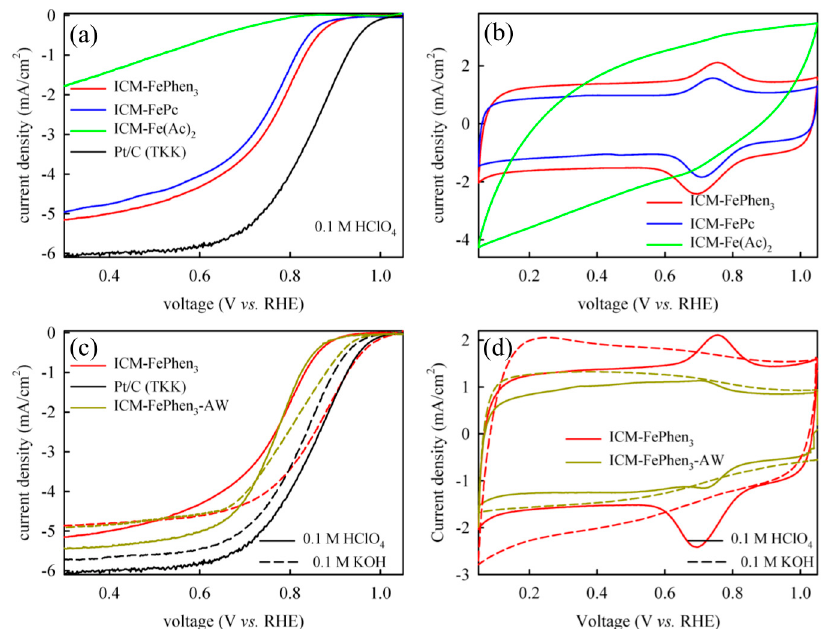
Figure 1. Electrochemical evaluation of ionothermal carbonization method (ICM)-derived Fe–N–C catalysts prepared from different iron precursors. ( a ) Oxygen reduction reaction (ORR) polarization curves measured in O 2 -saturated 0.1 M HClO 4 with a scan rate of 20 mV/s at 1600 rpm. ( b ) Cyclic voltammograms (CVs) measured in N 2 -saturated 0.1 M HClO 4 with a scan rate of 20 mV/s. ( c ) ORR polarization curves of ICM-FePhen 3 catalyst before and after an acid wash (AW), measured in O 2 -saturated 0.1 M HClO 4 or 0.1 M KOH with a scan rate of 20 mV/s at 1600 rpm. ( d ) CVs measured in N 2 -saturated 0.1 M HClO 4 or 0.1 M KOH with a scan rate of 20 mV/s. Results obtained with a commercial Pt/C catalyst (Tanaka Kikinzoku Kogyo (TKK, Japan), 46.7 wt.% Pt, anodic scan) are presented as a reference. The catalyst loading for Fe-N-C is 800 μ g/cm 2 . The Pt loading is 10 μ g Pt /cm 2 .